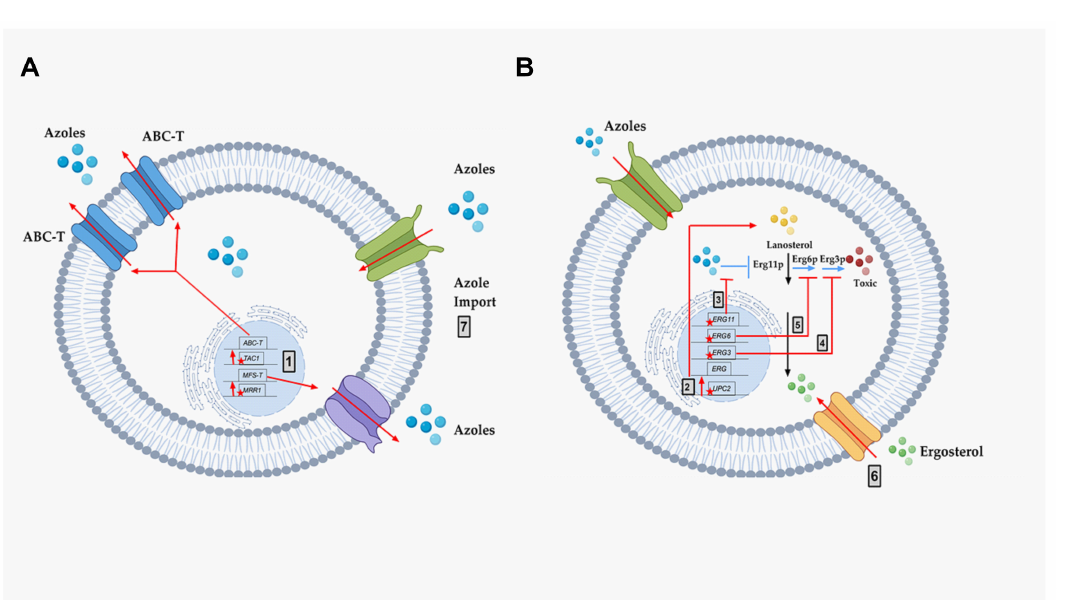
Figure 4. The molecular mechanisms of azole resistance. A schematic representation of known molecular mechanisms of azole resistance. Black arrows represent the normal ergosterol pathway, including lanosterol (Yellow Circles), ergosterol (Green Circles), and ergosterol inhibition of UPC2. Blue arrows represent the mechanism of action of azole drugs (Blue Circles), including the inhibition of target Erg11p, and production of toxic diol (Red Circles) through several steps, including Erg6p and Erg3p. The genes important for resistance are diagrammed within the nucleus as black rectangles in their chromosomal locations (black line). Red stars (mutations) and red arrows represent the different known molecular mechanisms of drug resistance in pathogenic fungi: ( A ) Azole resistance mechanism via efflux pump activities. ( B ) Azole resistance mechanism via altered ergosterol biosynthesis. Grey box 1—Increased efflux of azoles due to point mutations in MRR1 and TAC1 (stars), resulting in over-expression of MFS-Ts and ABC-Ts, respectively. ( B ) Grey box 2—Point mutations in UPC2 causing increased expression throughout the ergosterol ( ERG ) pathway. Grey box 3—Point mutations in ERG11 that prevent azole binding. Grey box 4—Point mutations in ERG3 that prevent the formation of toxic sterol. Grey box 5—Point mutations in ERG6 that prevent the formation of toxic sterol. Grey box 6—Sterol import that reduces the need for sterol biosynthesis. Grey box 7—Altered azole import that reduces intracellular azoles. This figure was created with the help of biorender.com.